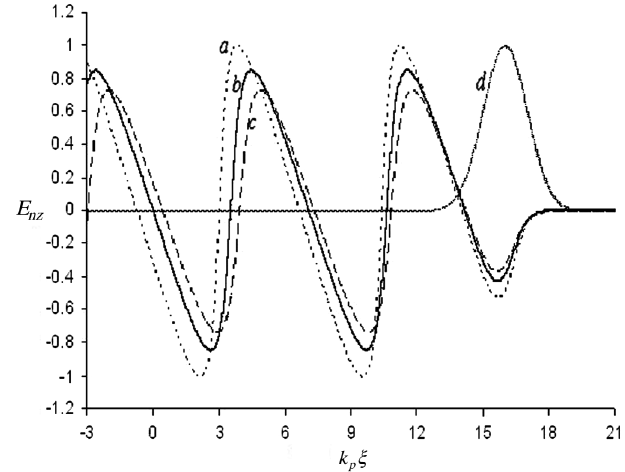
FIG. 3. Variation of normalized longitudinal electrostatic Þ with k (cid:5) for (cid:1) ¼(cid:4) 1 (curve a ), (cid:1) ¼ 0 (curve b ), wakefield ð E nz p ¼ 32 (cid:9) m , and L ¼ 7 : 2 (cid:9) m . and (cid:1) ¼þ 1 (curve c ) for a 0 ¼ 1 : 0 , (cid:8) p Curve d shows the evolution of the laser